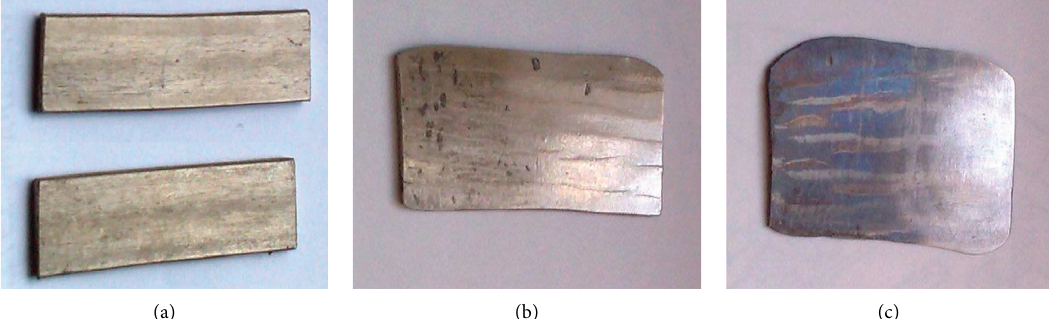
Figure 11: Te shape of the samples: (a) after the second stage of deformation (dimensions: 2.5 × 17 × 50 mm); after the third stage according to the TE and rolling mode: (b) at an initial temperature of 340 ° C, rolling in 3 passes (8%, 13%, and 19%), h � 1.6mm; (c) at an initial temperature of 385 ° S , rolling in 2 passes (40% and 20%), h � 1.2mm.